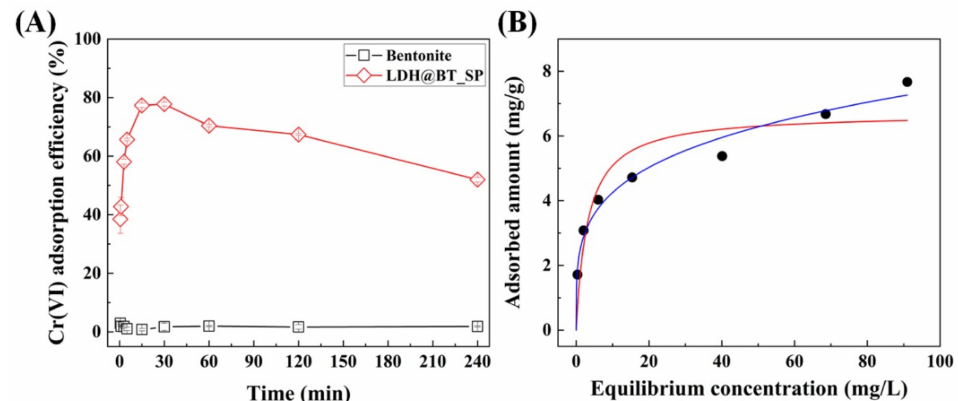
Figure 6. ( A ) The chromate adsorption efficiencies of the pristine bentonite and the LDH–BT_SP with 50 wt.% LDH ( A ) as a function of time (initial chromate concentration = 10 mg/L; adsorbent concentration = 1 g/L; contact time = 0.5–240 min). ( B ) The chromate adsorption isotherm results (black dot) and fitting profile of the LDH–BT_SP with the Langmuir (red line) and Freundlich (blue line) isotherm models (initial chromate concentration = 2–100 mg/L; adsorbent concentration = 1 g/L; contact time = 2 h).